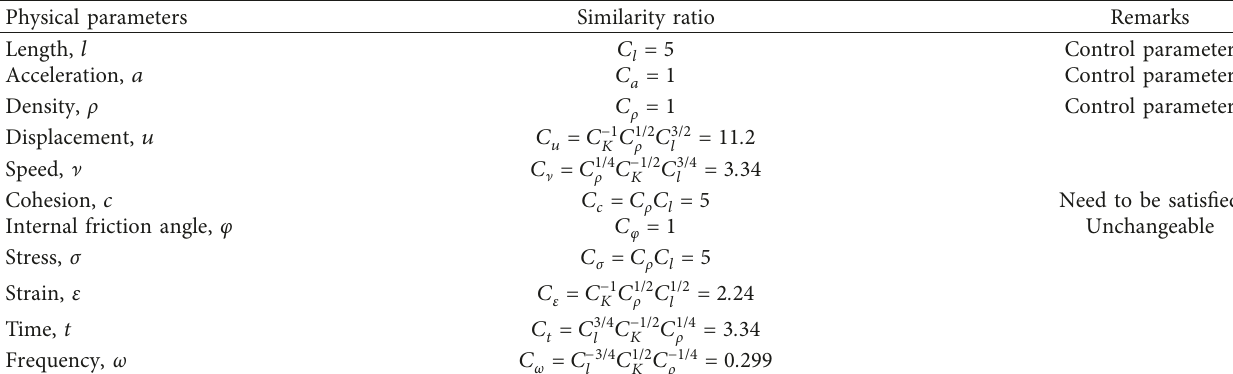
Table 1: Similarity ratio of slope parameters.